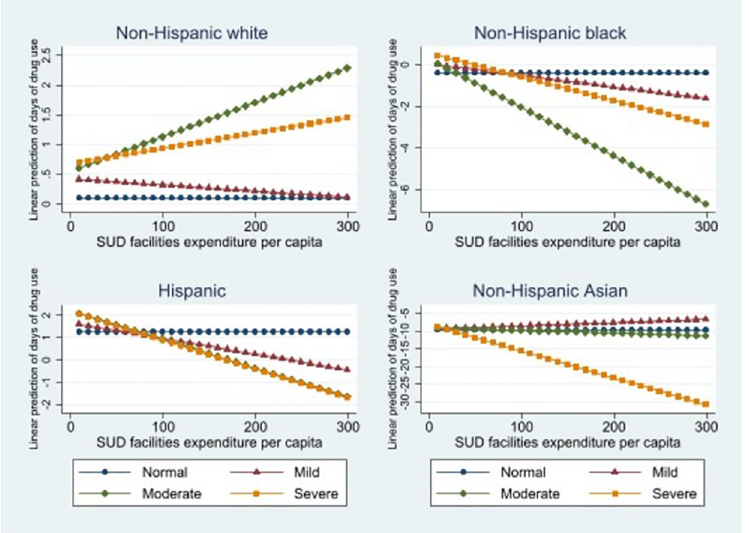
Fig 2. Linear prediction of drug use by racial/ethnic